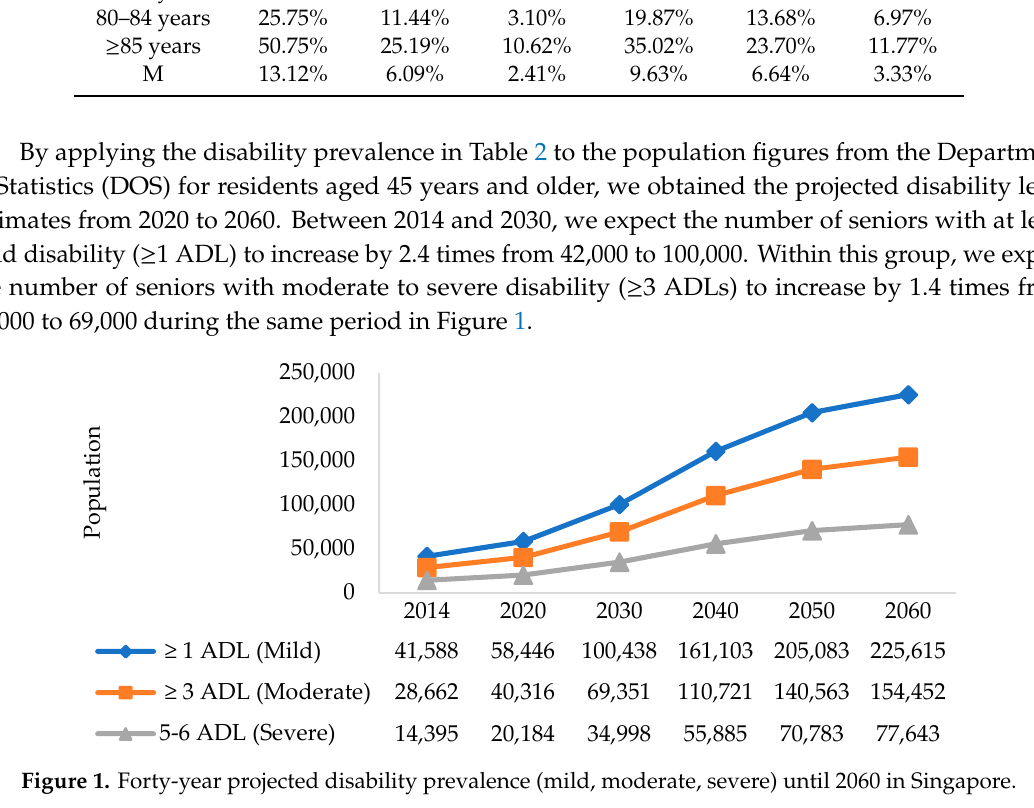
Figure 1. Forty-year projected disability prevalence (mild, moderate, severe) until 2060 in